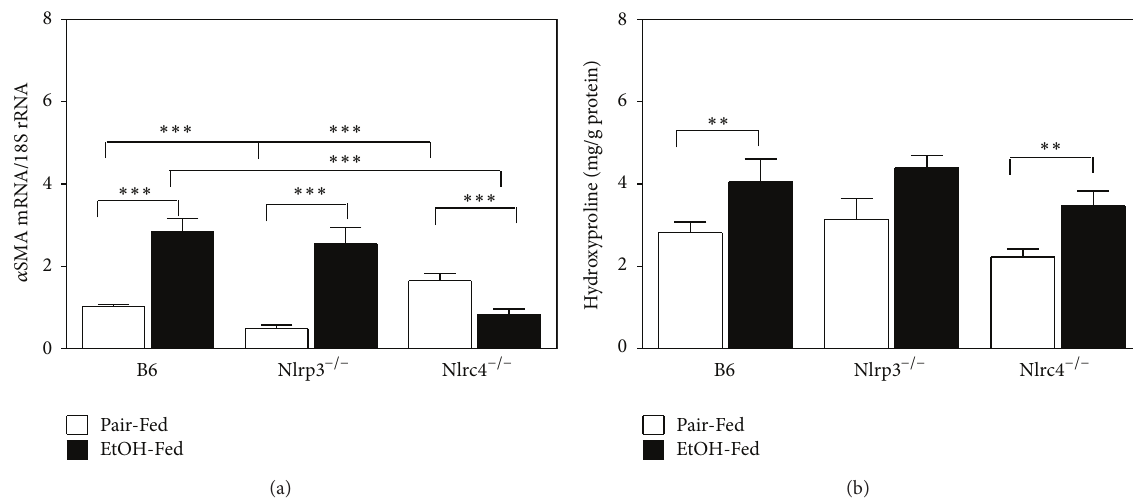
Figure 4: Measurement of 𝛼 SMA and hydroxyproline. Total RNA was isolated from livers of C57BL/6J (B6), Nlrp 3 −/− , and Nlrc 4 −/− mice fed Lieber-DeCarli ethanol-containing diet (+EtOH) or pair-fed controls (Pair-Fed). Expression of (a) 𝛼 SMA mRNA was measured and normalized by 18S rRNA. (b) Hydroxyproline was measured in protein homogenates by ELISA and normalized by protein concentration in the homogenates. The values are the means ± SEM for 𝑛 = 4 –6 mice per group. Values represent the mean ± SEM with ∗∗ 𝑃 < 0.05 , ∗∗∗ 𝑃 < 0.001 by Student’s 𝑡 -test.